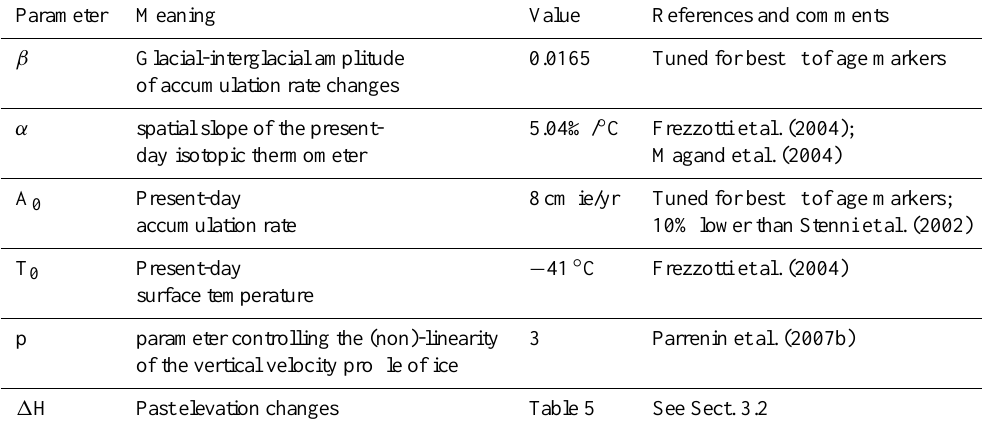
Table 4. Input parameters used in the 1-D ice flow model (Parrenin et al., 2007b).